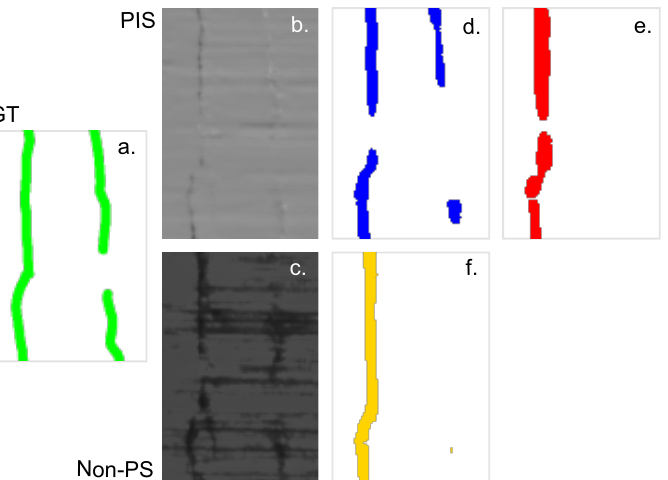
Figure 4. Qualitative evaluation based on a 4.25 × 6.25 mm patch. Annotation mask ( a ), PIS-PS surface structure model ( b ), non-PS image ( c ), and prediction masks from CNNs trained on PIS-PS ( d ), PIS-Raw ( e ), and non-PS ( f ) data.The distinct crack left was detected with all three preprocessing strategies, i.e., PIS-PS, PIS-Raw, and Non-PS.The very fine crack right was only detected by PIS-PS, at least partly with regards to the